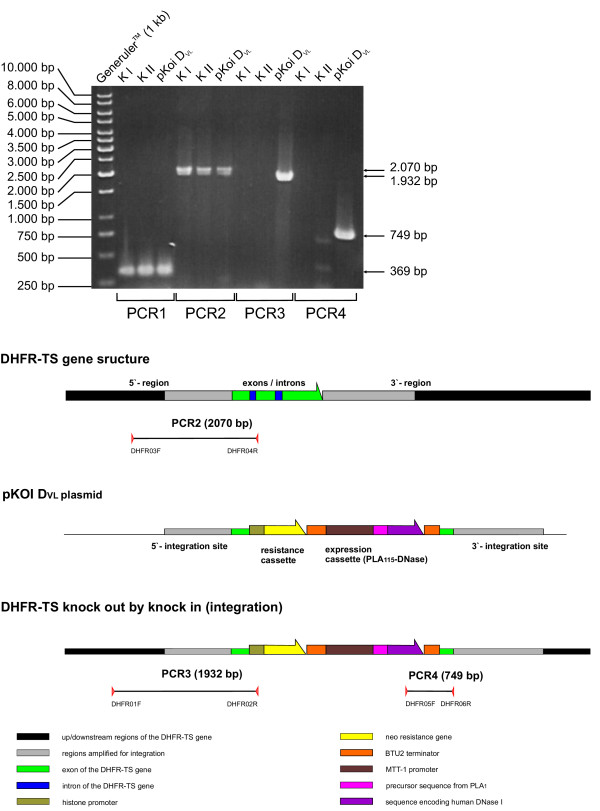
Proper integration of DHFR-TS knock out construct. This figure illustrates the PCR approach to determine that the knock out/-in construct has integrated into the DHFR-TS gene locus. Three different cells were tested: KI is a wildtype control, KII are cells transfected with a plasmid carrying only the disrupting cassettes but no DHFR-TS gene sequences and pKOI DVL are cells transformed with the pKOI DVL plasmid. PCR1 is a control reaction amplyfing 369 bp of the beta-hexosaminidase gene. PCR2 is to detect endogenous DHFR-TS (note that in the pKOIDVL cells there still is a wildtype gene in the MIC). PCR3 only yields PCR-product for correctly integrated pKOI DVL DNA. PCR4 shows that the full-length expression cassette has integrated. The first scheme illustrate the overall structure of the DHFR-TS gene, exons are coloured in green and introns in blue. The parts of the non-coding 5' and 3' regions of the DHFR-TS structure gene that we used as integration sites in the pKOI/pKOI DVL plasmids are coloured in grey. The next scheme gives on overall structure of the pKOIDVL expression construct that was used for transformation and integration into the MAC. The third scheme illustrates the disruption of the endogenous DHFR-TS structure gene by proper integration of the resistance and expression cassettes into the MAC.